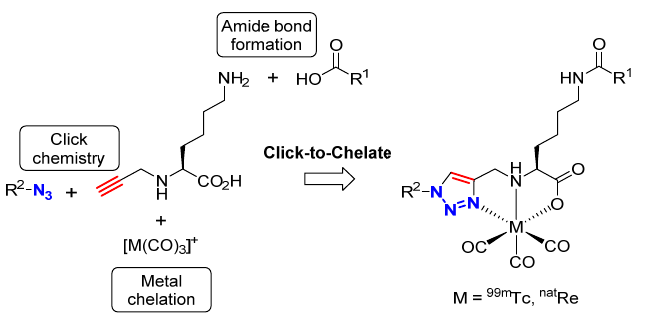
Figure 1. Assembly of 99m Tc-labeled conjugates by “Click-to-Chelate”.